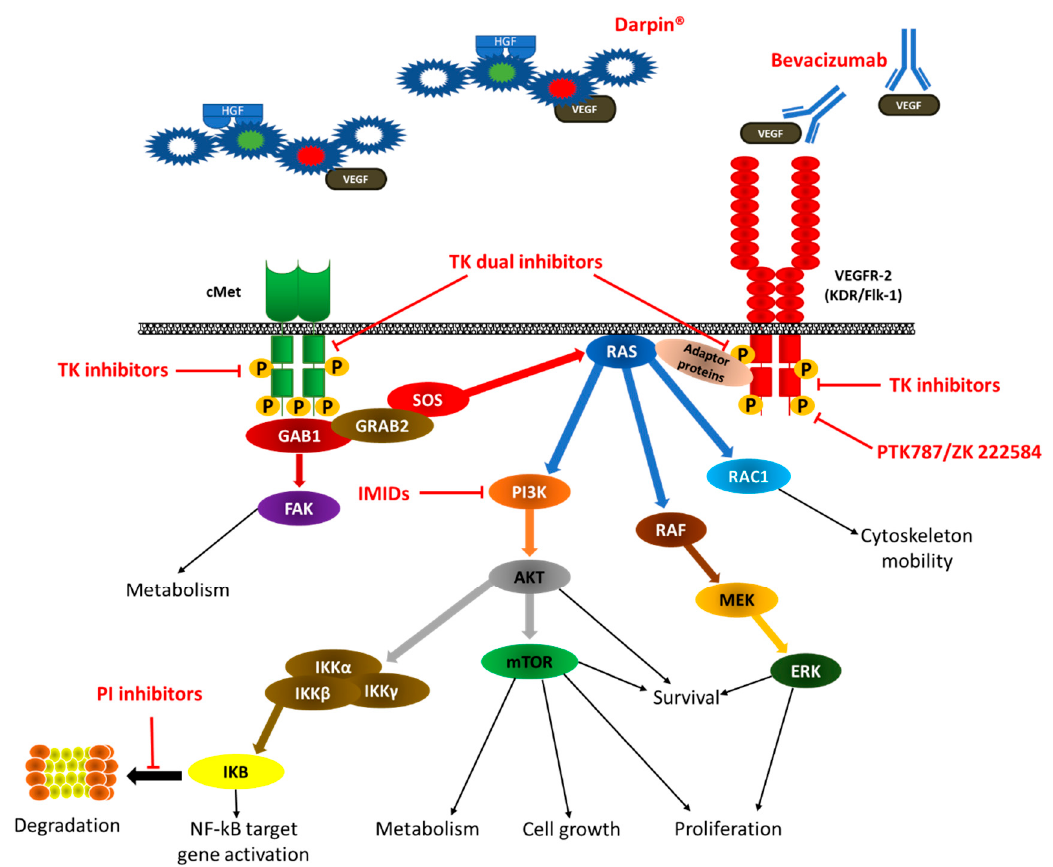
Figure 3. VEGFR and cMet pathways in MM microenvironment. Sites of inhibition of anti-VEGF drugs. VEGF: vascular endothelial growth factor; VEGFR: VEGF receptor; KDR: kinase insert domain receptor; Flk-1: fetal liver kinase-1; HGF: hepatocyte growth factor; cMet: tyrosine-protein kinase Met or HGF receptor; GAB1: GRB2-associated-binding protein 1; FAK: focal adhesion kinase; PI3K: phosphatidylinositol 3-kinase; AKT: also know as protein kinase B (PKB); IKK: inhibitor of nuclear factor kappa-B kinase subunits; IKB: inhibitor of nuclear factor kappa-B kinase complex; mTOR: mammalian target of rapamycin; MEK: Mitogen-activated protein kinase kinase; ERK: extracellular signal-regulated kinase; RAC1: Ras-related C3 botulinum toxin substrate 1; NF-kB: nuclear factor kappa-light-chain-enhancer of activated B cells; PI: proteasome inhibitors; IMIDs: immunomodulators; TK: tyrosine